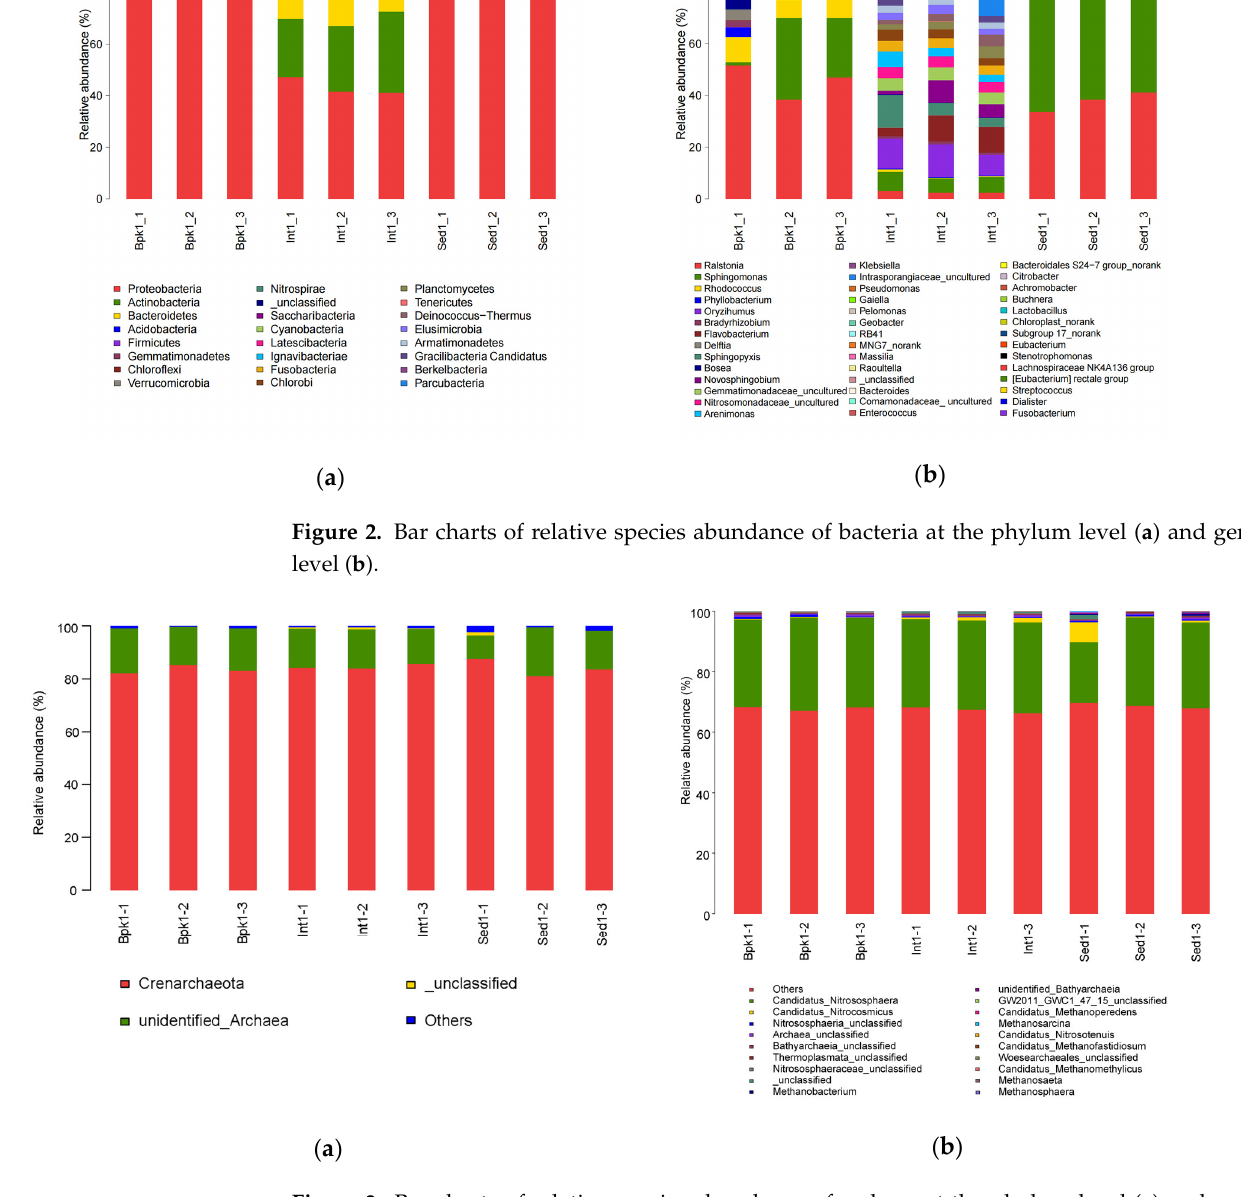
Figure 3. Bar charts of relative species abundance of archaea at the phylum level ( a ) and genus level ( b ).